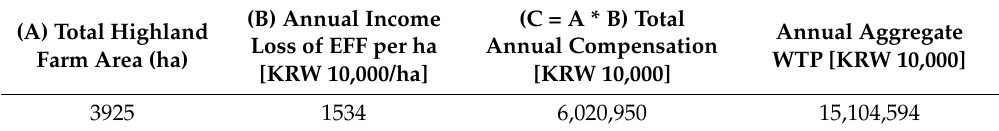
Table 5. The calculated compensation costs based on highland farm size, compared with annual